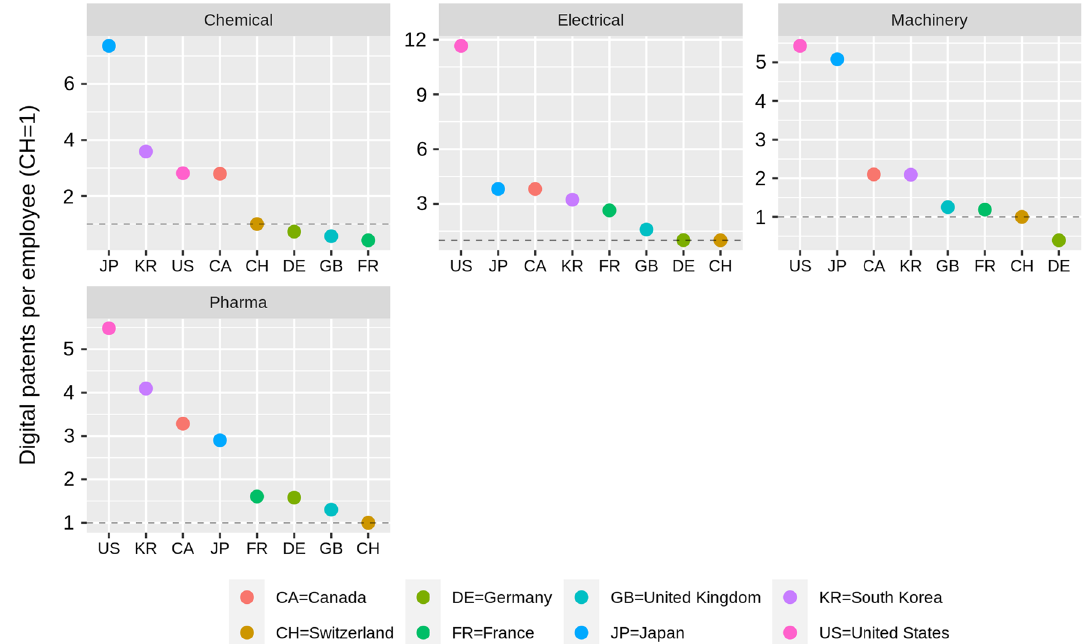
Fig. 7 Digital patents per employee across industries and countries. Notes : The y-axis shows digital patents of the years 2010–2015 relative to the average number of employees between 2010 and 2015 per industry and country normalized by the value of Switzerland. For the number of employees, we used data from the OECD-STAN database. Unfortunately, we could not calculate the number of employees for Medical Technology and Computer/ICT, as these are composed of different NOGA sub-industries. Moreover, values for China are not included in the STAN database